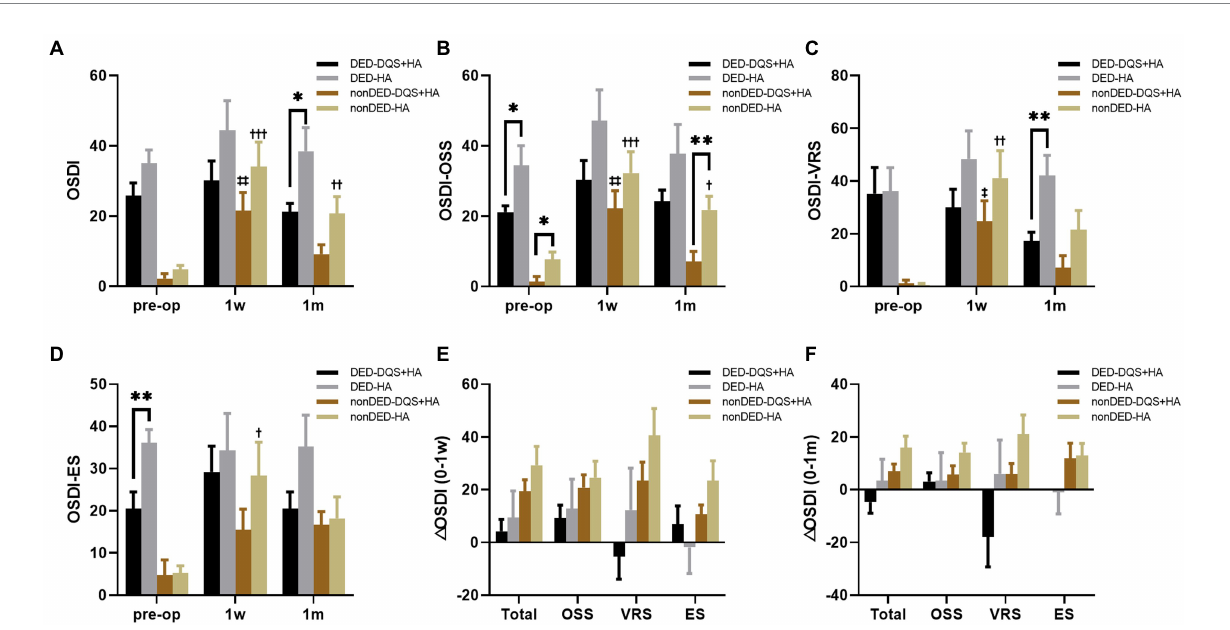
FIGURE 4 Changes in OSDI score (A) , OSS (B) , VS (C) , ES (D) after FS-LASIK and the alterations from preoperative to postoperative 1 week (E) and postoperative 1 month (F) in dry eye patients and non-dry eye patients. Mean value ± standard error. The sample sizes of DED-DQS + HA group, DED-HA group, nonDED- DQS + HA group, and nonDED-HA group were 13, 9, 7, and 11 patients, respectively. * p < 0.05 and ** p < 0.01 between the combination group and the HA group in each subgroup by independent samples t -test or Mann–Whitney U test. ‡ p < 0.05, ‡‡ p < 0.01 between preoperative visit and postoperative visits in the combination group and † p < 0.05, †† p < 0.01, ††† p < 0.001 between preoperative visit and postoperative visits in the HA group by one-way repeated measures ANOVA or Friedman test. OSDI, ocular surface disease index; OSS, ocular symptom score; VRS, vision-related score; ES, environmental score; DED, dry eye